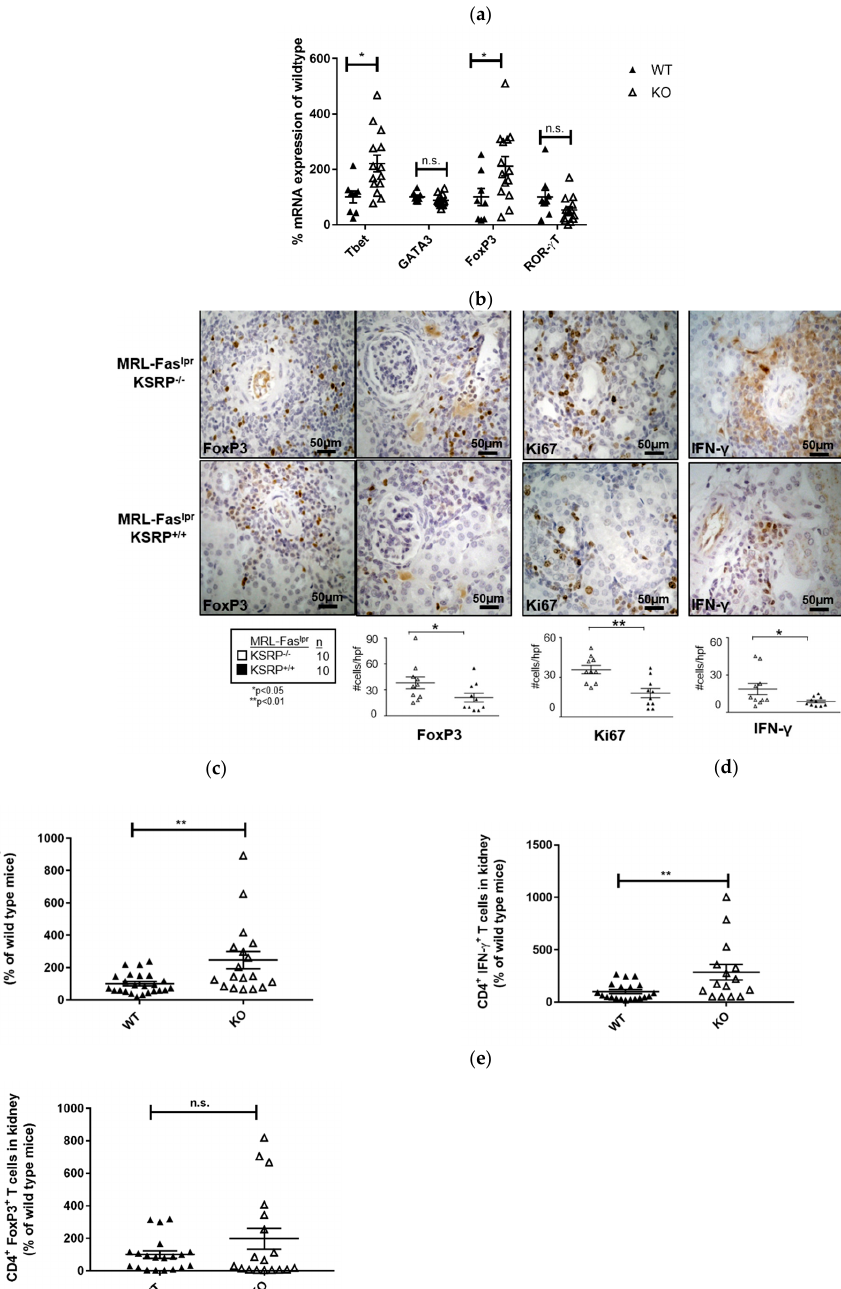
Figure 4. Characterization of T cell population in the kidneys of 19 and 15-week-old female MRL-Fas lpr KSRP − / − mice compared to MRL-Fas lpr KSRP +/+ mice ( a ) RNA was isolated from the kidneys of 19-week-old female MRL-Fas lpr KSRP − / − mice (KO) and MRL-Fas lpr KSRP +/+ mice (WT). T cell lineage-specific transcription factor mRNA expression of T-bet, GATA3, ROR γ T and FoxP3 were analyzed by qRT-PCR and normalized to the mRNA expression of Pol2a. Data presented are the mean ± SEM of the relative mRNA expressions based on WT female 19 weeks (100%) 9 to 14 animals per genotype (*: p < 0.05; n.s.: not significantly different from WT, T -TEST). ( b ) Immunostaining was used to analyze intra-renal frequency of FoxP3, Ki67 and IFN- γ producing cells in the kidneys of female 19-week-old MRL-Fas pr KSRP +/+ and MRL-Fas lpr KSRP − / − mice. Data presented are the mean ± SEM of the score with 10 animals per genotype (**: p < 0.01, *: p < 0.05 compared to WT, TTEST). Representative image of immunostaining with 40x magnification. ( c – e ) FACS was used to analyze intra-renal frequency of CD4 + , CD4 + -IFN- γ + and FoxP3 + cells in the kidneys of female 15-week-old MRL-Fas lpr KSRP +/+ and MRL- Fas pr KSRP − / − mice. Data presented are the mean ± SEM of the relative cell numbers compared to MRL-Fas lpr KSRP +/+ mice (19 to 23 animals per genotype) (**: p < 0.01, n.s.: not significant, compared to WT, t